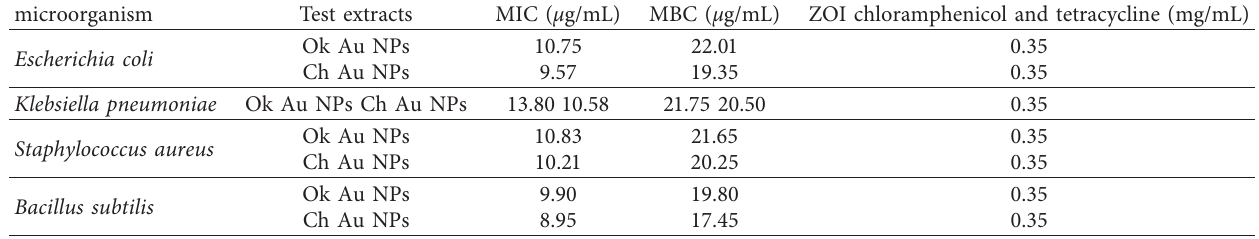
Table 1: Antibacterial characteristics of Au NPs.